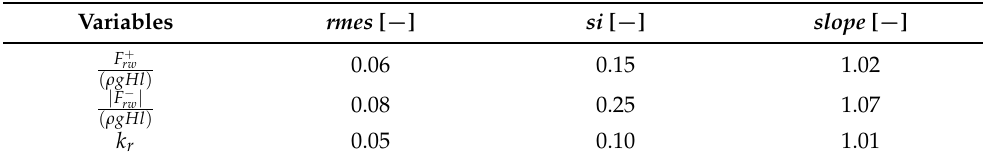
Table 3. Performances parameters of the numerical model: the root mean square discrepancy between the two sets of data ( rmse ), the scatter index ( si ), and the slope . Variables rmes [ −